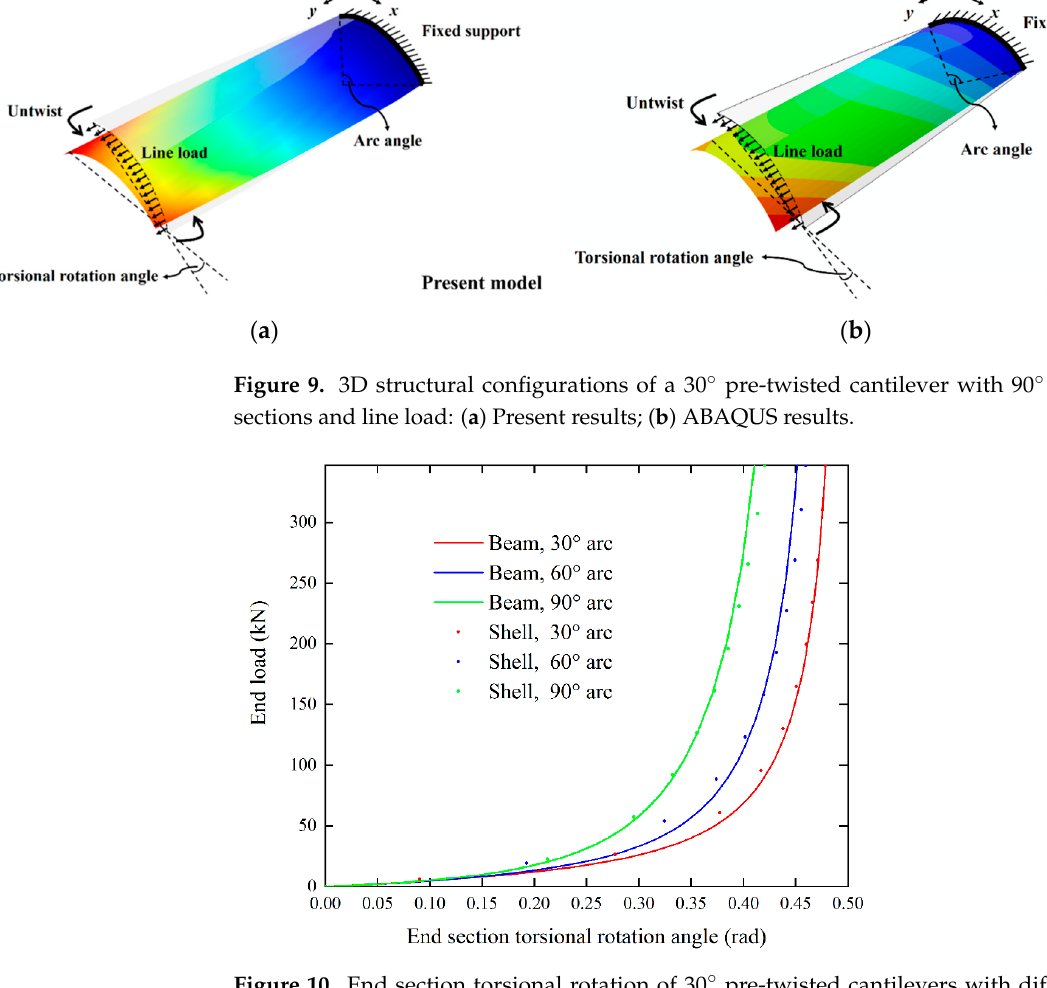
Figure 10. End section torsional rotation of 30° pre-twisted cantilevers with different arc profile cross sections.